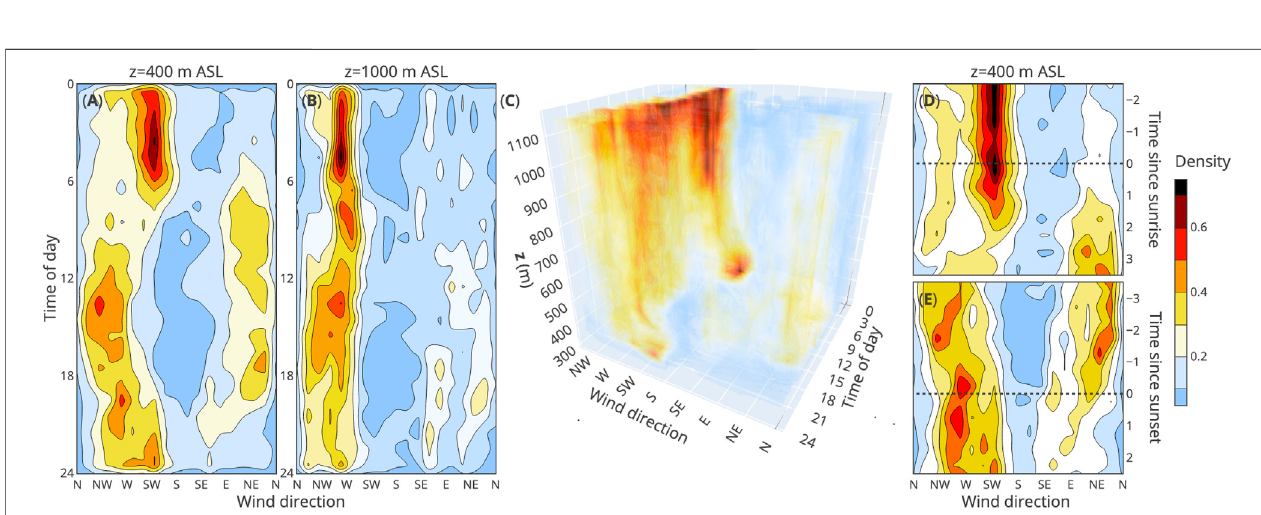
FIGURE 6 | Frequency of occurrence of wind direction against time of day and altitude above sea level ( z ; m ASL) for the period 14 March 2017 to 29 June 2017. (A,B) showcross-sectionsat400and1,000 m, whereaspanels (D,E) showcross-sectionsat400 mwithtime ashourssincesunrise andsunset,respectively.Seetext for